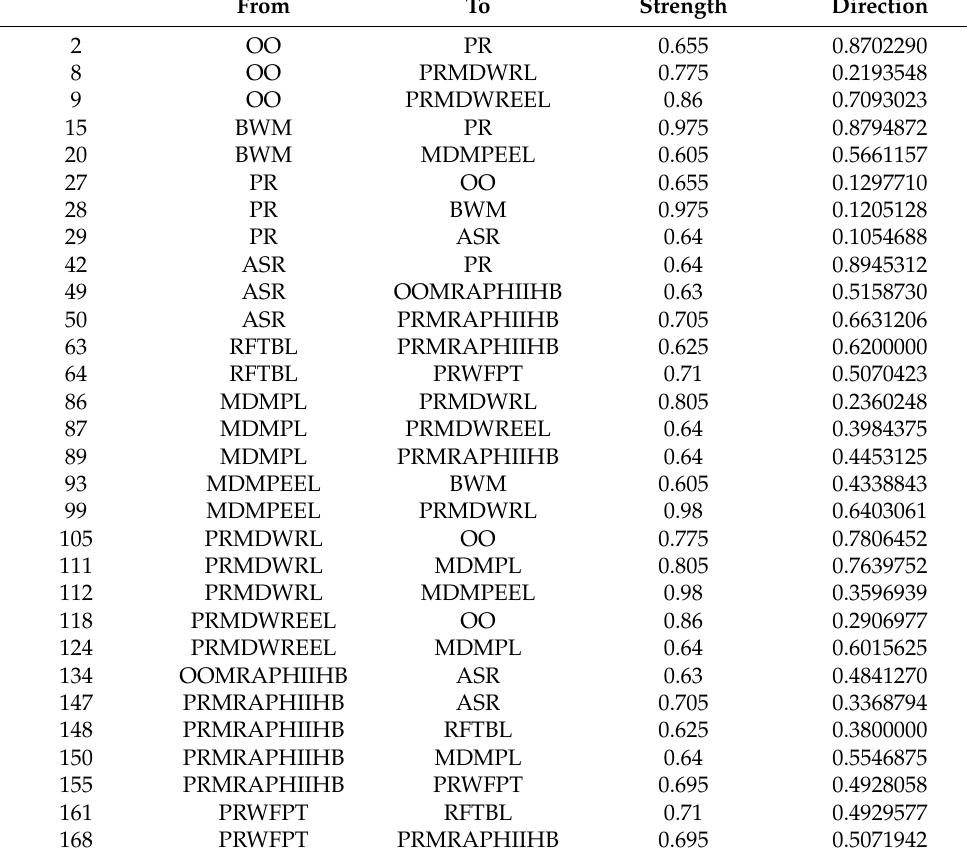
Table 3. Probabilities of inclusion of all possible arcs and their